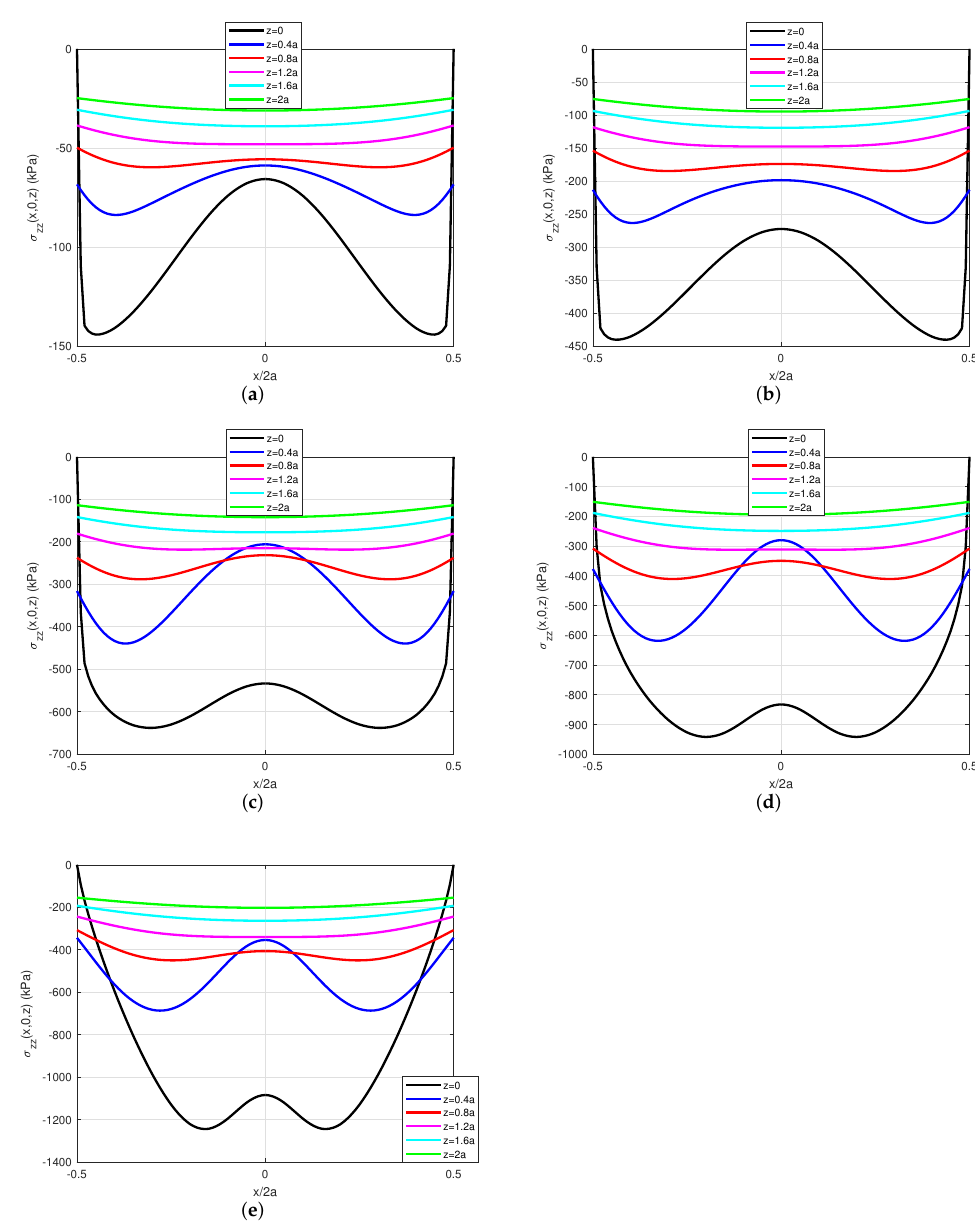
Figure 14. Vertical compressive stress σ zz in central cross sections with depth: ( a ) Case N1-T0.9; ( b ) Case N2-T0.9; ( c ) Case N3-T0.9; ( d ) Case N4-T0.9; ( e ) Case